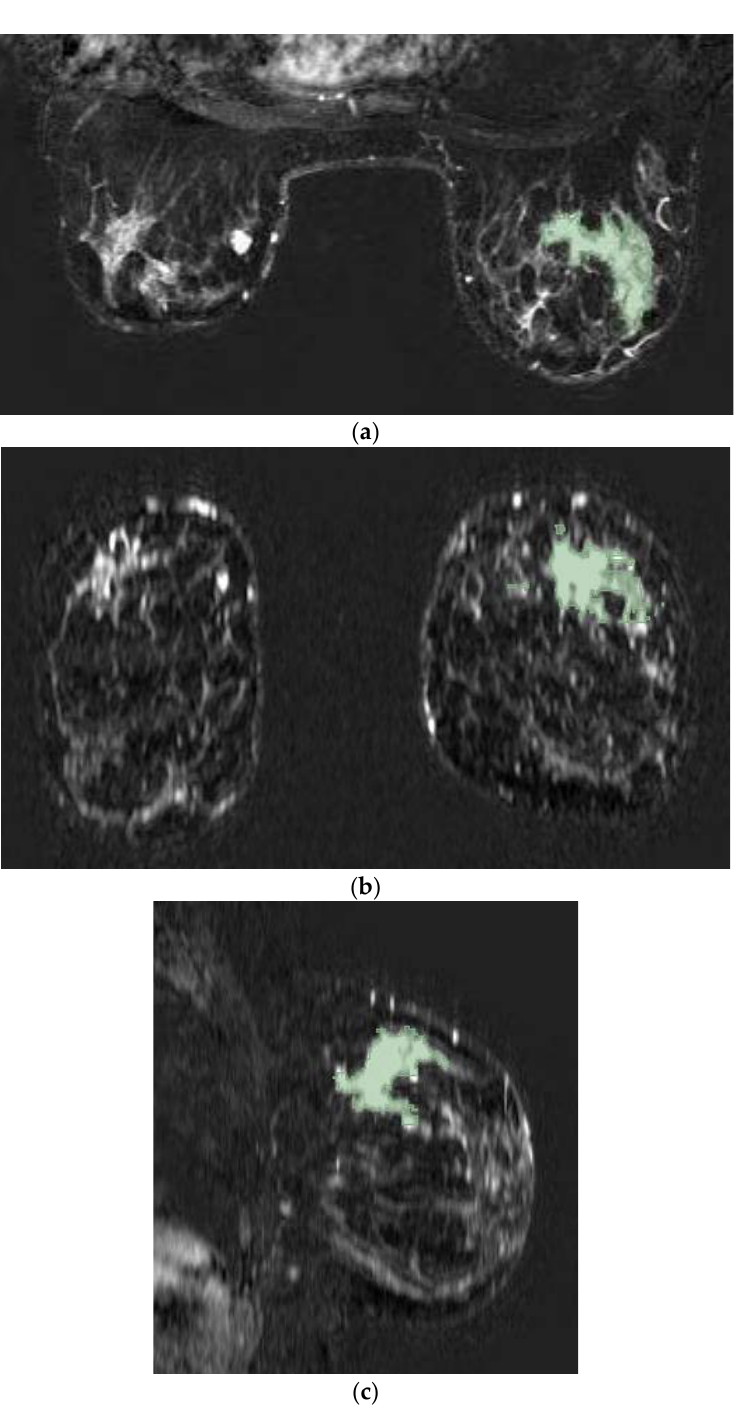
Figure 1. Tumor lesion segmentation using 3D Slicer software in axial ( a ), coronal ( b ), and sagittal ( c ) MRI projections during the second phase of the post-contrast sequence as demonstrated in a case involving a 56-year-old woman with right invasive ductal breast cancer with unifocal mass-like lesion characterized by spiculated margins and heterogeneous enhancement after contrast medium administration with curve SI/T type